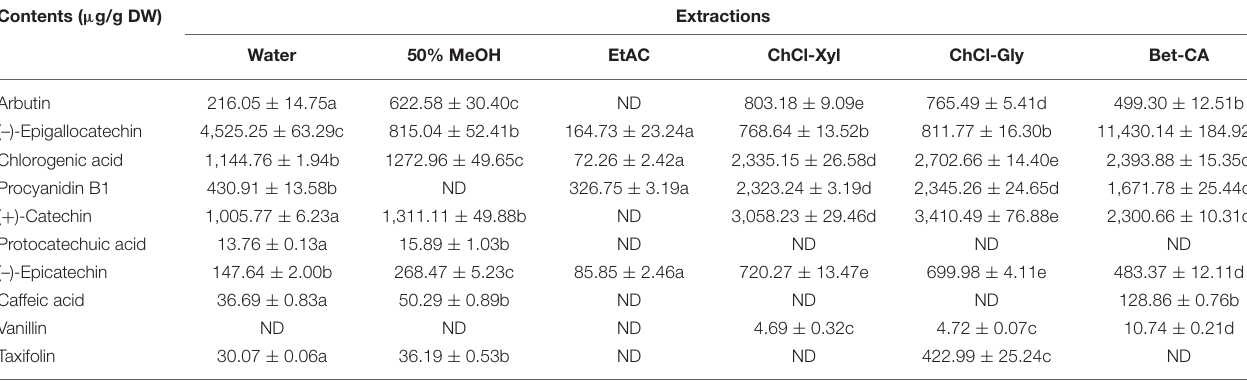
TABLE 3 | The contents of the main phenolic compounds of the CIOPs extracts with different solvents.